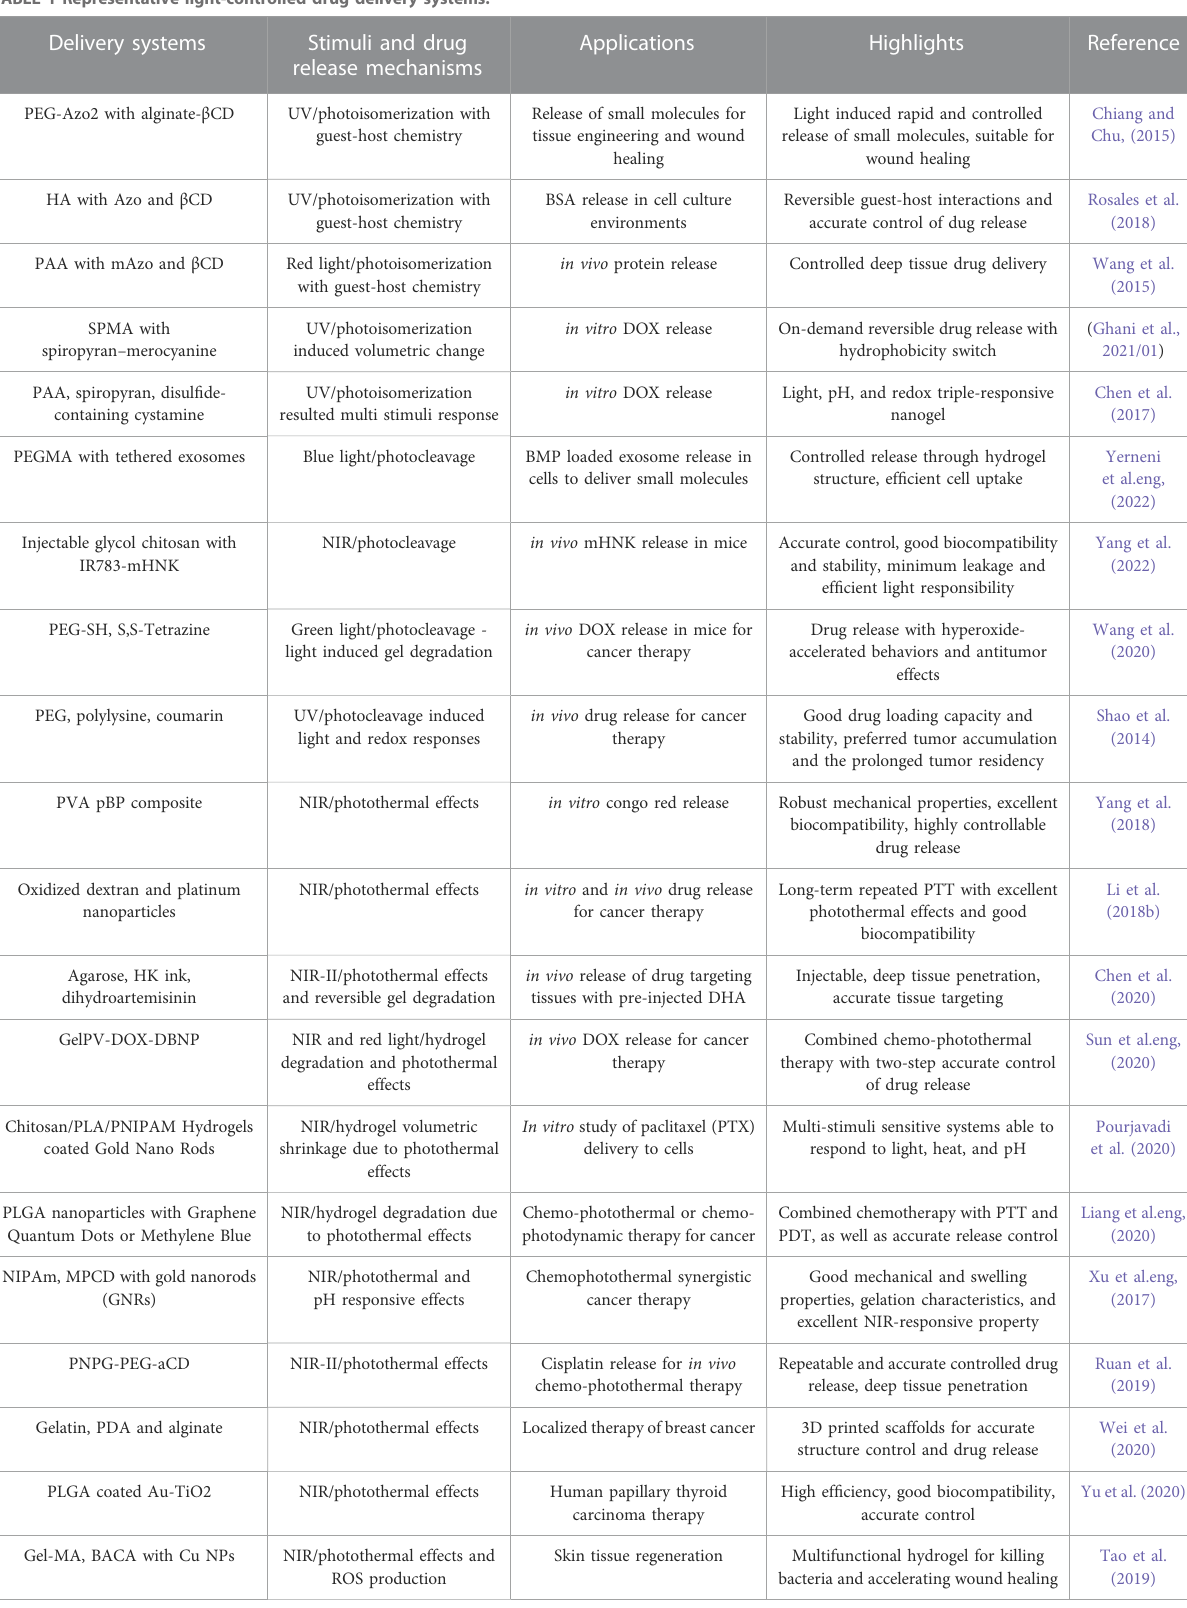
TABLE 1 Representative light-controlled drug delivery